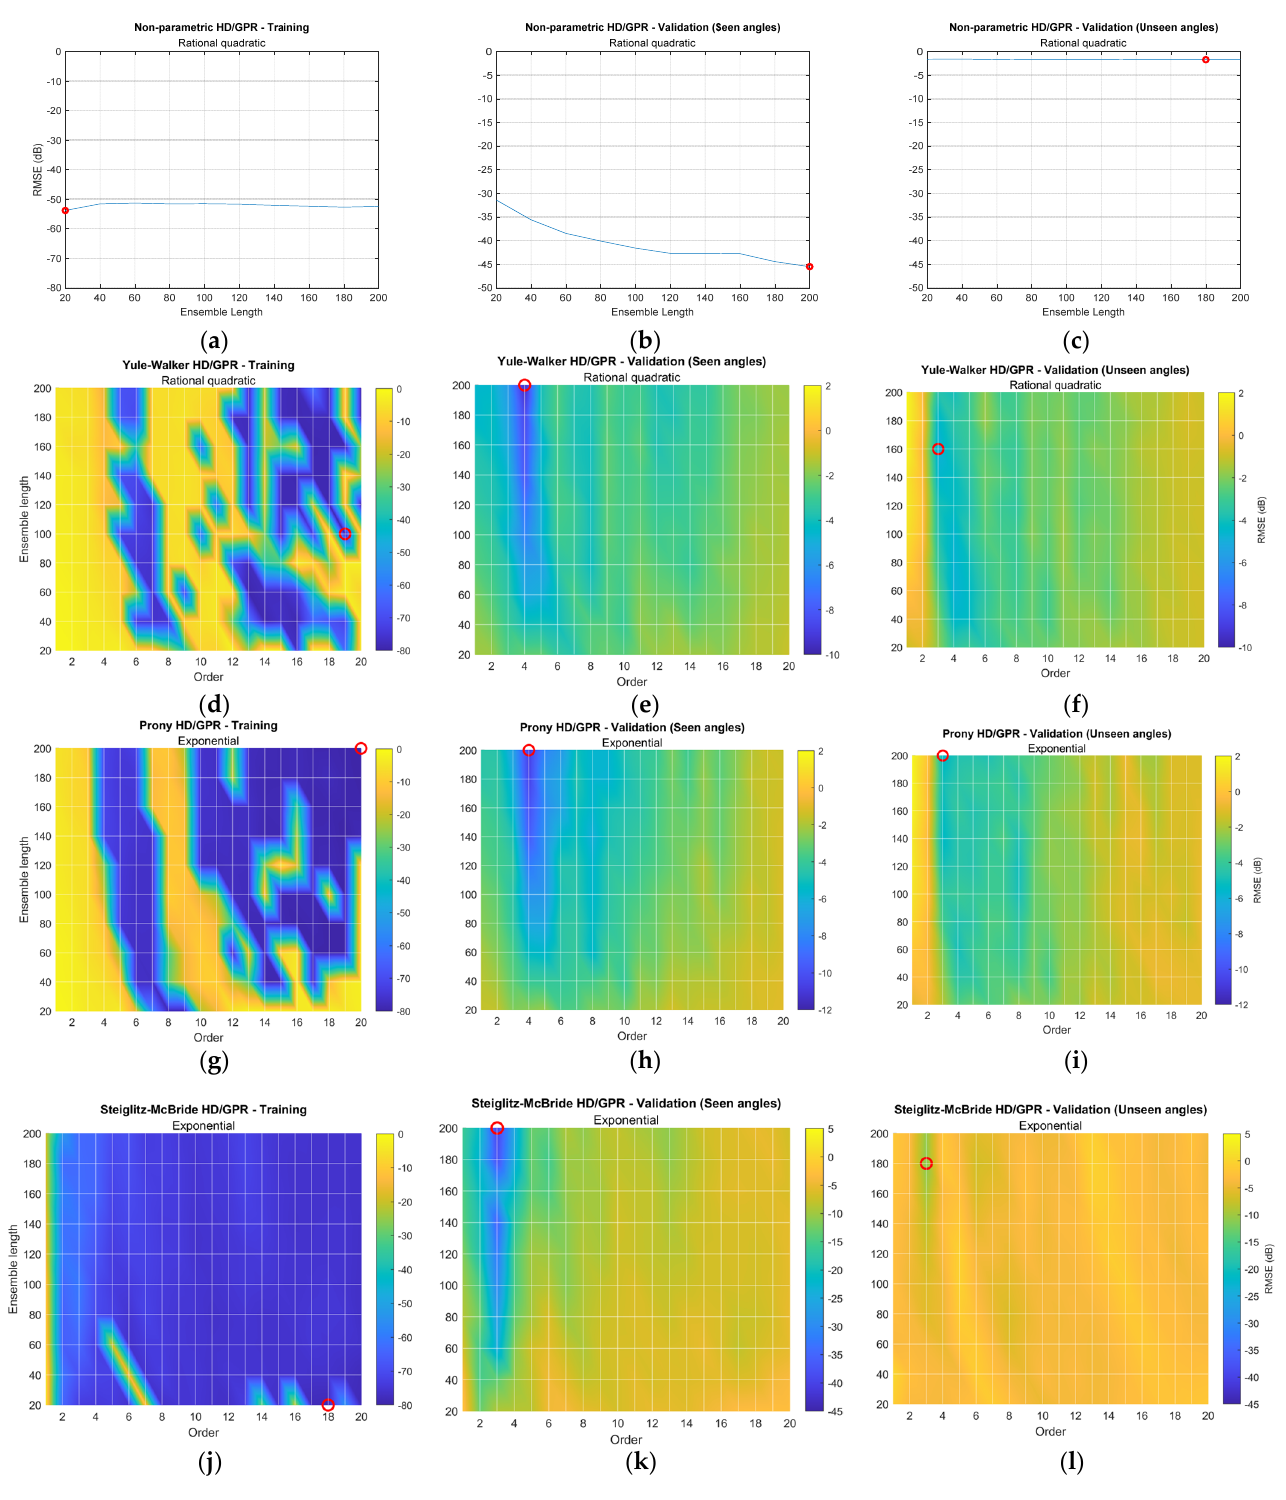
Figure 11. Simulated RMSE distribution for selected GPR kernel function. The red circle indicates the minimum RMSE location. (Training: 1998 iterations; validation seen-angle: 3996 iterations; and validation unseen-angle: 3996 iterations.) ( a – c ) Non-parametric HD/GPR—Training and valida- tions; ( d – f ) Yule–Walker HD/GPR—Training and validations; ( g – i ) Prony HD/GPR—Training and validations; ( j – l ) Steiglitz–McBride HD/GPR—Training and validations.